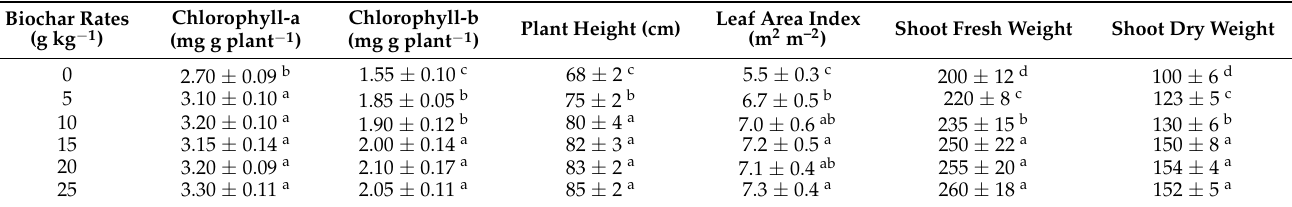
Table 5. Effect of SWB on the growth of pearl